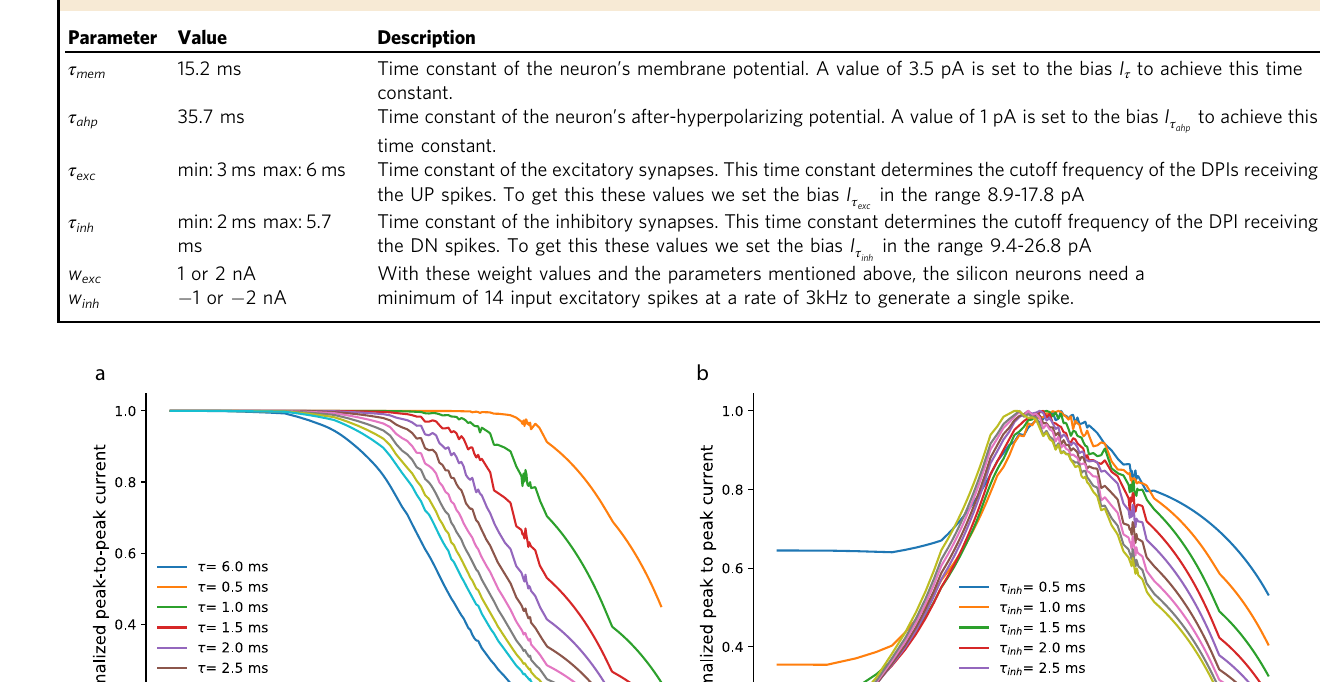
Table 4 Synapse parameters of the SNN model depicted in (Fig. 1d).